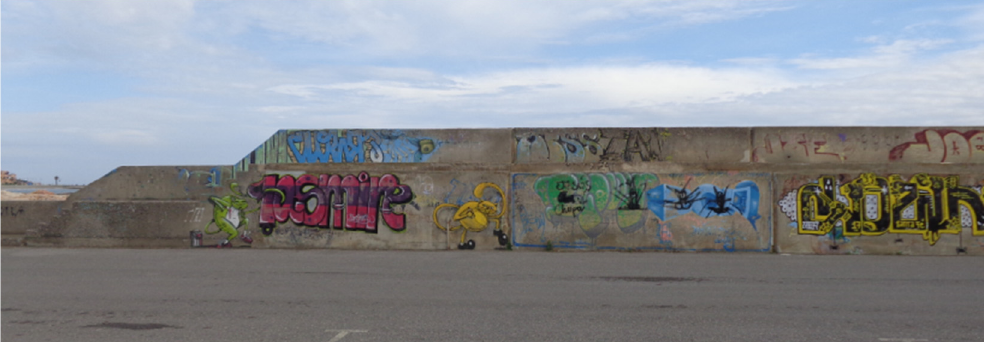
Figure 10. Maintenance of seawalls, Almerimar (Almería), ES.